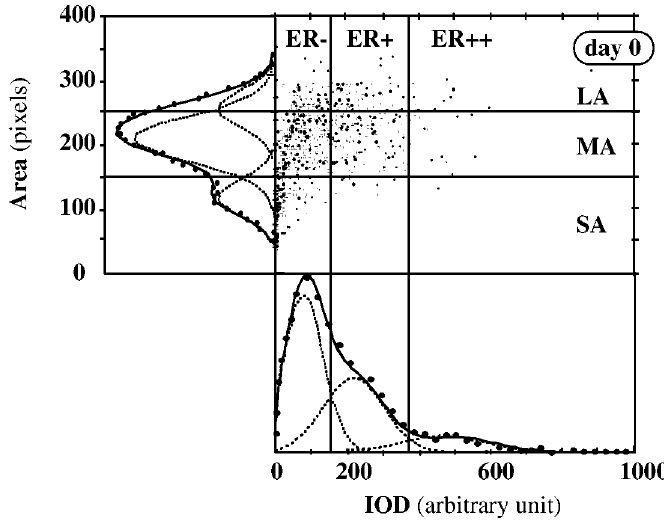
Fig. 3. Bidimensional relative plot of integrated optical density (IOD) and nuclear area (A) of MCF-7 cells at day 0 (upper right box). In the lower right box the relative distribution of IOD (dot plot) is fitted by the sum (solid curve) of three Gaussians (dashed curves) that describe the three subpopulations of nuclei with different contents of estrogen receptors (ER − , ER + , ER ++ ). In the upper left box the relative distribution of A (dot plot) is fitted by the sum (solid curve) of three Gaussians (dashed curves) that describe the three subpopulations of nuclei with different areas (SA, MA, LA). The thresholds (Gaussians intersections) between the different subpopulations are gated in the three